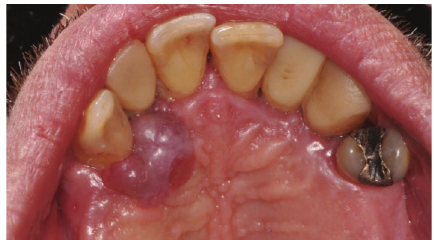
Figure 1: Intraoral examination: note the exophytic mass on the palatal aspect associated with the canine and dental implant.